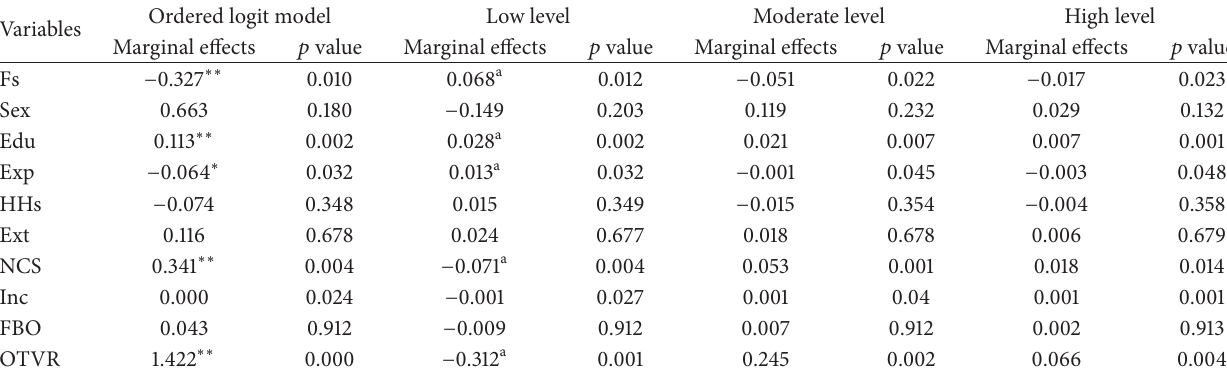
Table 5: Marginal effects of ordered logit model and the individual awareness levels.